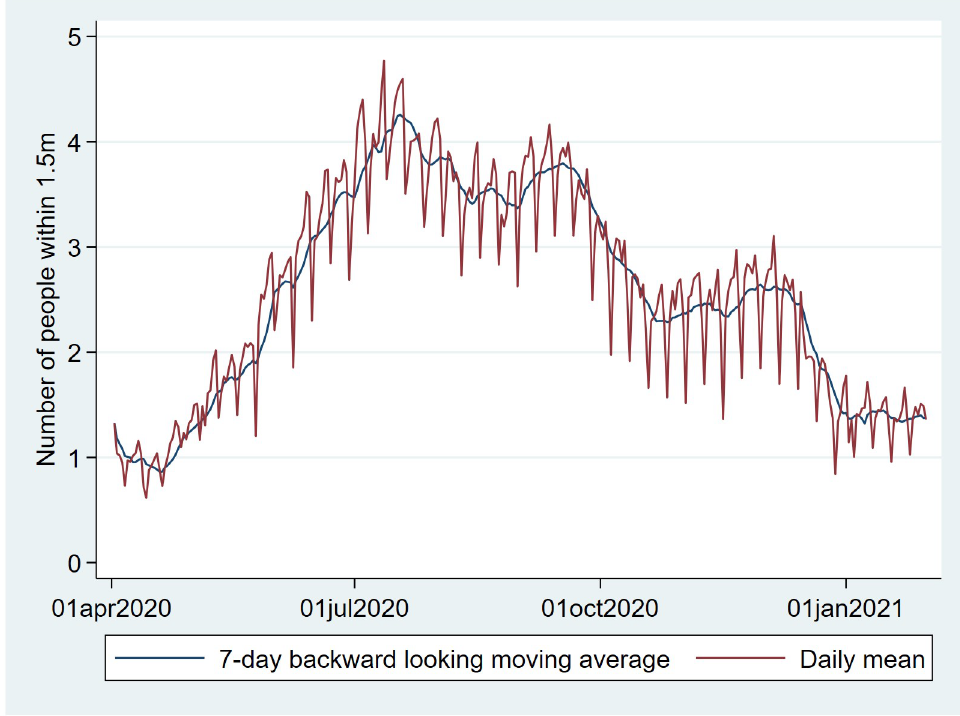
Fig 11. Daily mean number of people within 1.5 meters (with 7-day backward-looking moving average in black) September: Closing of restaurants. December: holidays, followed by closing of non-essential shops.